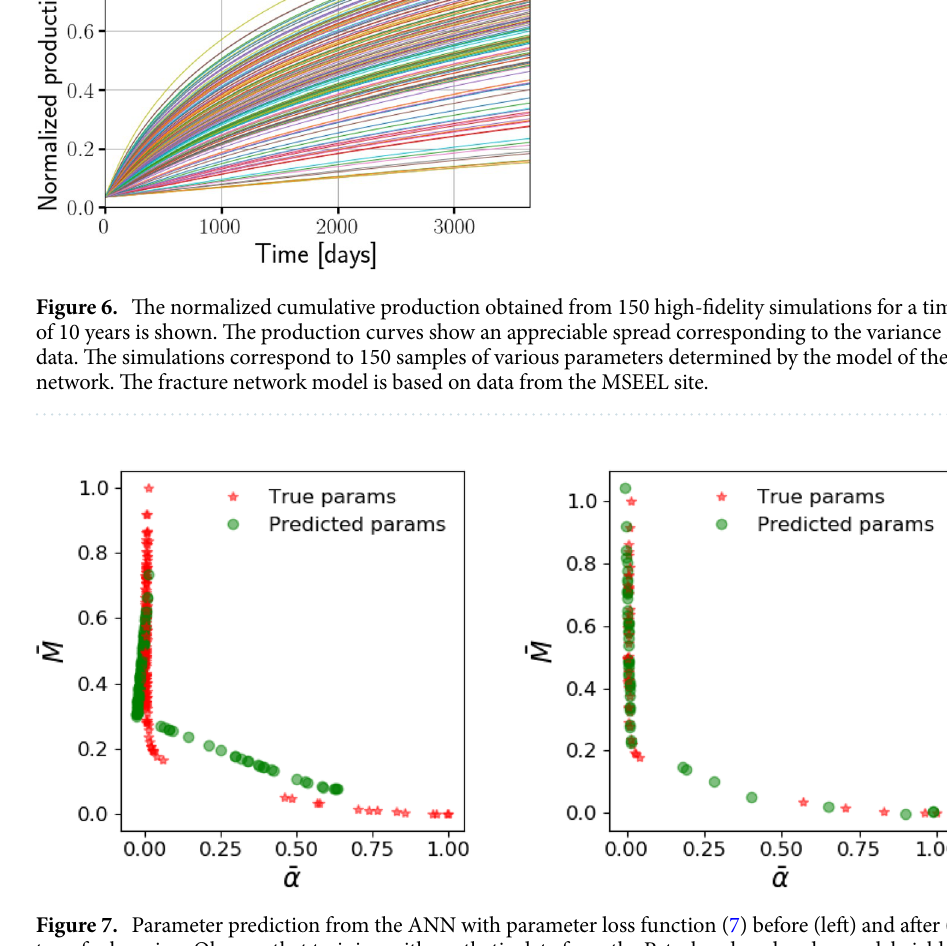
Figure 7. Parameter prediction from the ANN with parameter loss function (7) before (left) and after (right) transfer learning. Observe that training with synthetic data from the Patzek reduced-order model yields reasonable performance which improves remarkably after transfer learning. The distribution of the true parameters has a mean and standard deviation of 0.07 and 0.23 for ¯ α and 0.49 and 0.22 for ¯ M